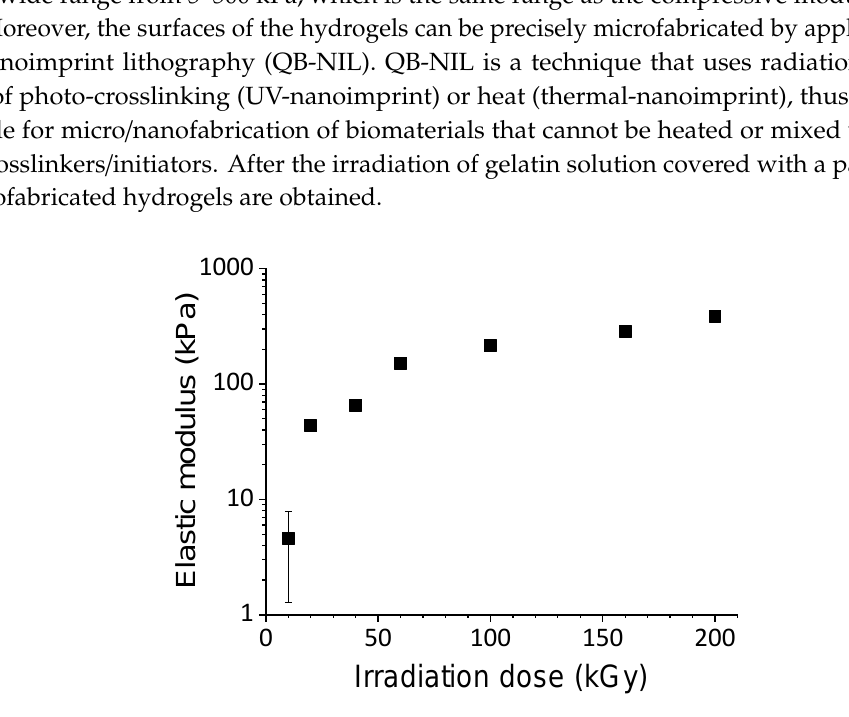
Figure 6. Elastic modulus of the radiation-crosslinked gelatin hydrogels.